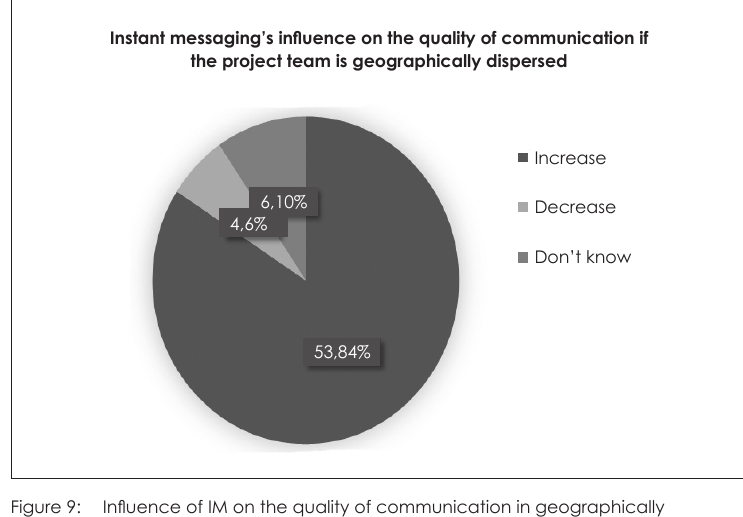
Video conferencing’s influence on the quality of communication if the project team is geographically dispersed